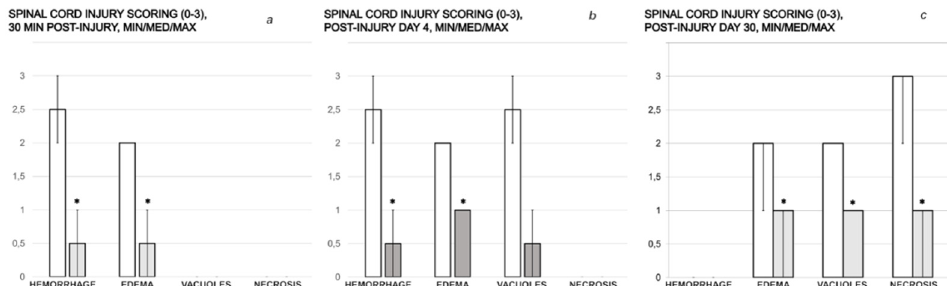
Figure 9. Spinal cord injury scoring (0–3), Min/Med/Max (hemorrhage, edema, vacuolation of tissue matter, necrosis) at the end of the experiment. Left ( a ). (i) One single intraperitoneal medication (saline 5 mL/kg b.w. (white bars); BPC 157 2 µ g/kg b.w. (grey bars)) was administered at 10 min post-injury, and rats were sacrificed at 20 min thereafter (i.e., 30 min after injury). Middle ( b ). (ii) One single intragastric medication (saline 5 mL/kg b.w. (white bars); BPC 157 10 ng/kg b.w. (gray bars)) was administered at day 4 post-injury, and rats were sacrificed at 20 min thereafter. (iii) Right ( c ). Assessment at the post-injury day 30. In those rats who already had a definitive tail paralysis, the therapy began on day 4, and it was continuously given perorally in drinking water (water 12 mL/rat/day (white bars); BPC 157 10 μ g/kg b.w., 0.16 μ g/mL (gray bars)) until day 30 post-injury. * p < 0.05, at least vs. the corresponding control.